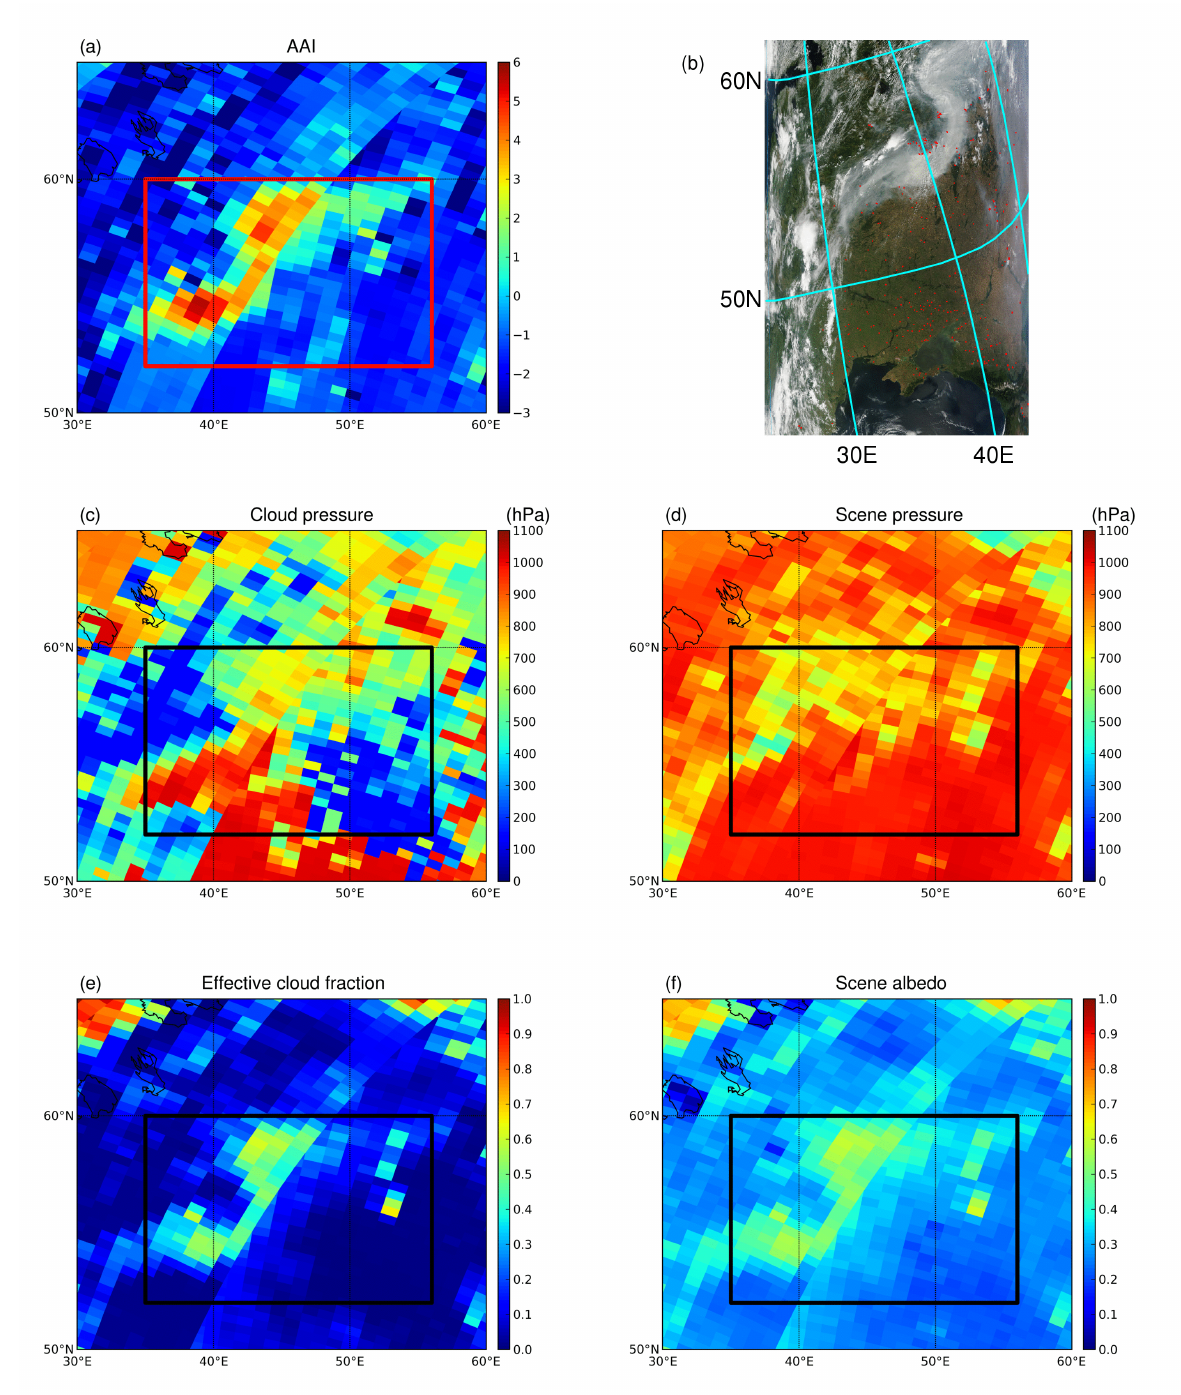
Fig. 18. (a) GOME-2 AAI image, (b) MODIS RGB image, (c) GOME-2 cloud pressure, (d) GOME-2 scene pressure, (e) GOME-2 effective cloud fraction, and (f) GOME-2 scene albedo for the smoke of Russian wild fires on 1 August 2010. The location of the plume is indicated with a box in the GOME-2 images. The plume in the box was measured around 06:50UTC. The MODIS measurement is taken at 08:45UTC. The red spots in the MODIS image indicate